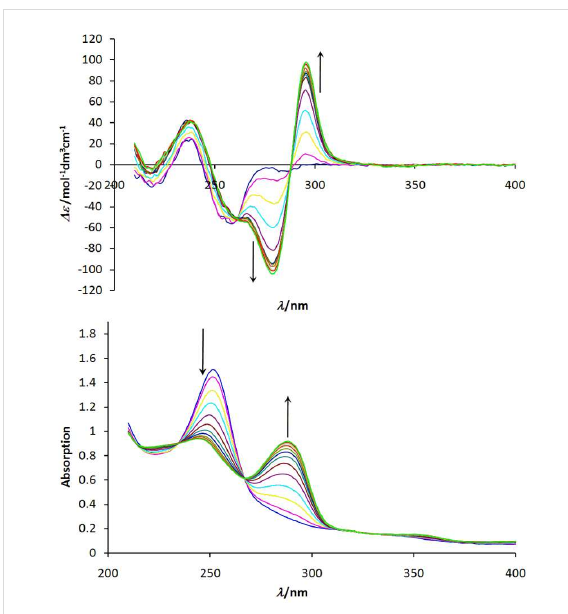
Figure 4: CD and UV absorption titration curves for complexation of ligand 1a -H 3 with lanthanum(III)nitrate hexahydrate [ 1a -H 3 ] = 10 −5 M; 10 −4 M NaOH. Top: CD spectra; bottom: UV absorption spectra.